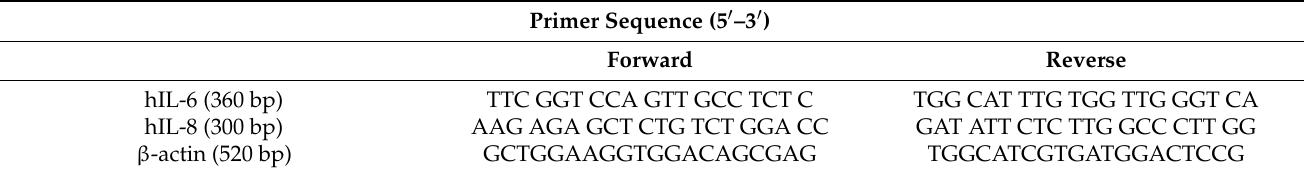
Table 1. The sequences of primers used in this experiment are summarized as follows. Primer Sequence (5 (cid:48) –3 (cid:48)